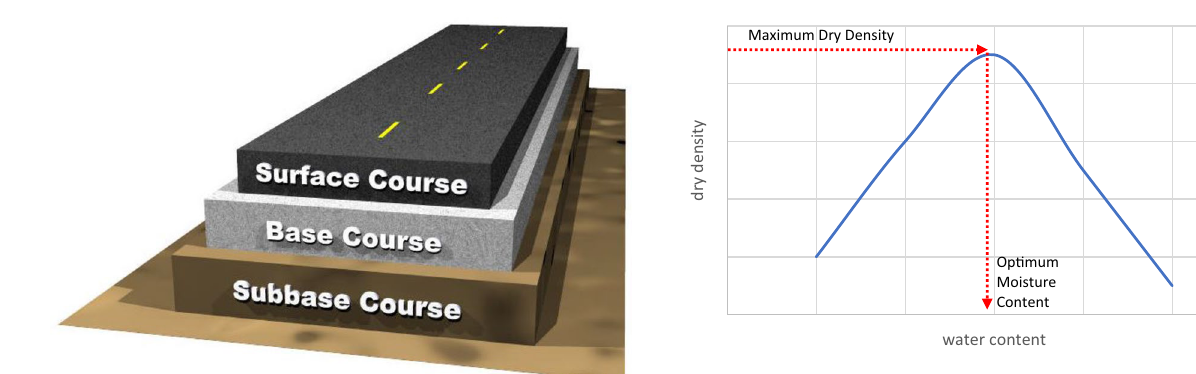
Fig. 1 Basic flexible pavement structure